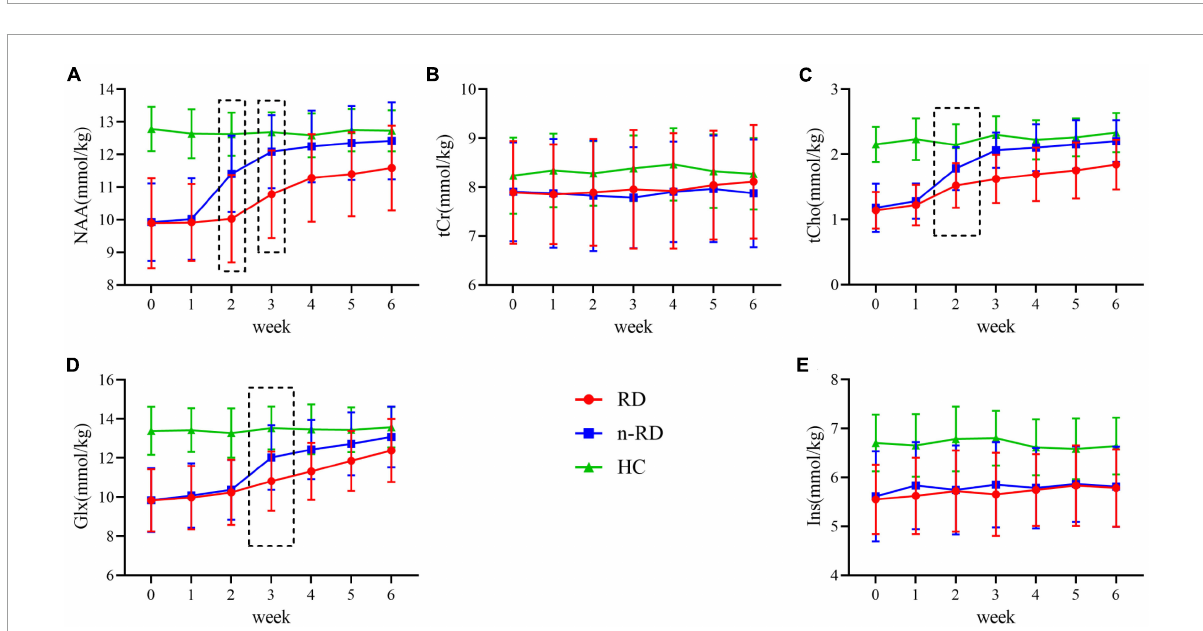
FIGURE3 (A–E) Longitudinal concentration change of metabolites over the follow-up period. The mean concentrations of metabolites in hippocampus for all subjects was divided into the following categories according to clinical diagnosis: healthy controls (HC/green, n = 20), refractory depression group (RD/red, n = 26) and non-refractory depression group (n-RD/blue, n = 41). NAA, N-acetyl-aspartate; tCho, phosphocholine and glycerophosphocholine; Glx, glutamate and glutamine; tCr, creatine and phosphocreatine; Ins, myo-inositol.